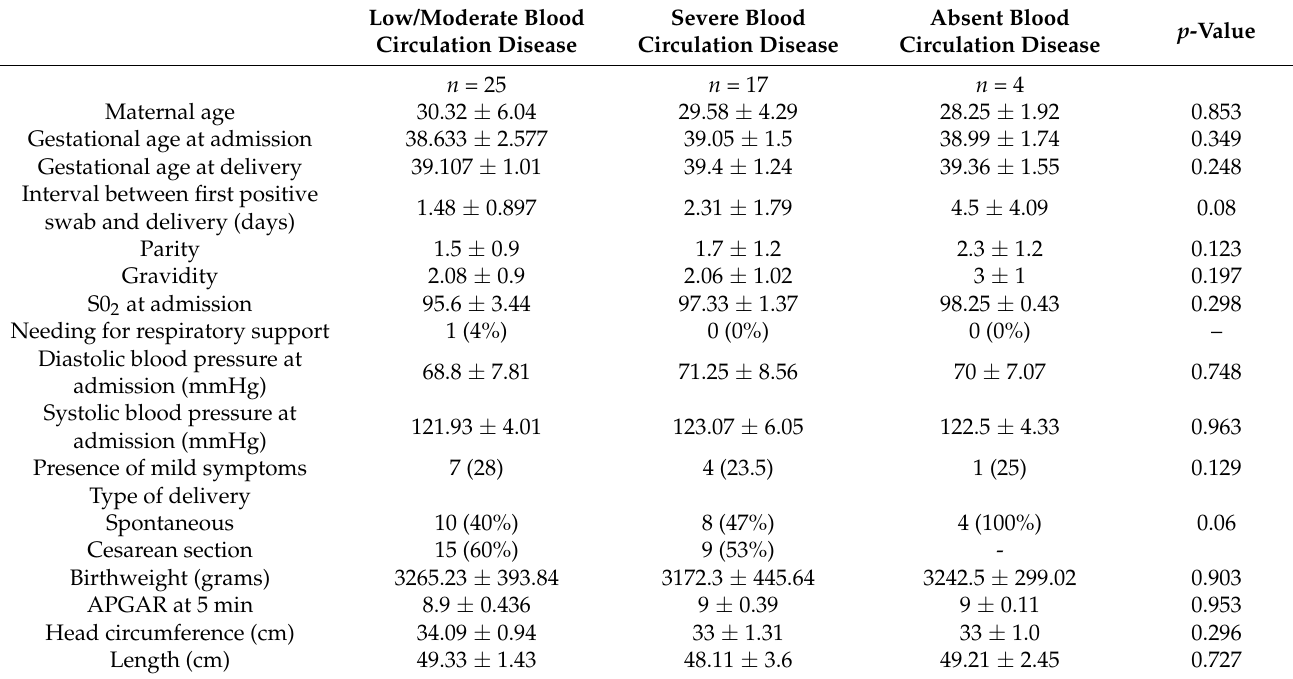
Table 3. Maternal and neonatal characteristics stratified by grade of blood circulation